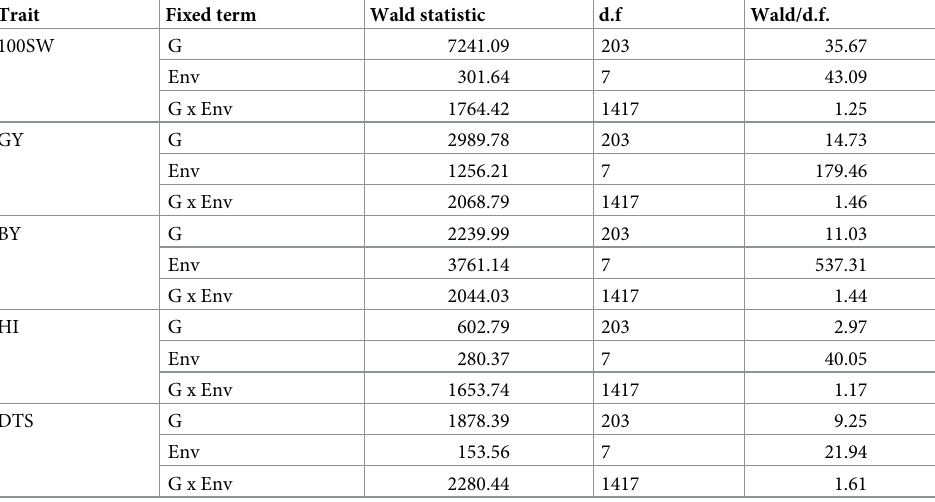
Table 3. Components of variance of yield components and drought tolerance score of 204 genotype in the field experiment at two locations during 2016 and 2017 seasons (Chi-sq. probability < 0.001). Degree of freedom